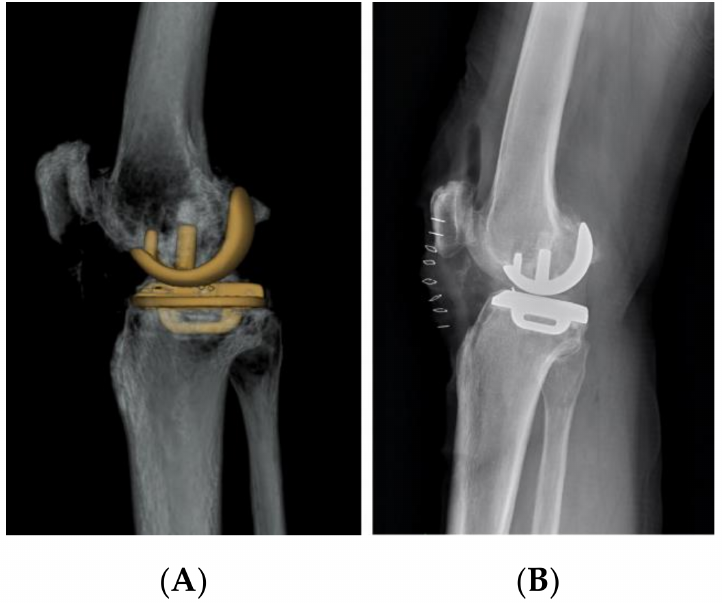
Figure 2. An example of ideal femoral component size of the knee lateral view and the same patient in CT scan showed a little overhang from posterior condyle bony contour. ( A ) 3D image. ( B ) Standard lateral